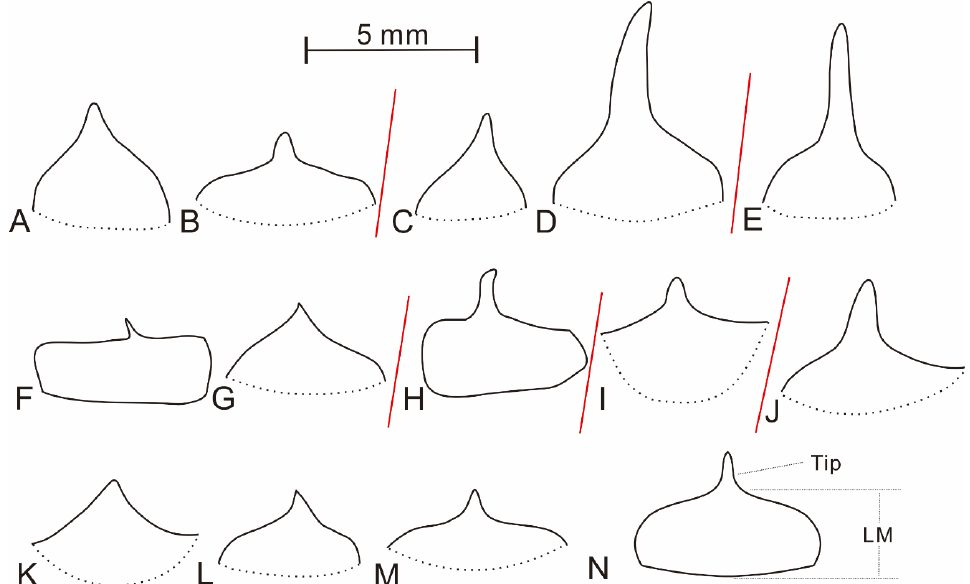
Figure 4. Line-drawings of leaf appearances of Barsassia ornata [17] from different localities and a leaf shape diagram. ( A ) From Figure 1 of [17], under the name of Barsassia ornata from the Middle Devonian of Barzas, southwestern Siberia, Russia. ( B ) From Figure 2 of [17], under the name of Barsassia ornata from the Middle Devonian of Barzas, southwestern Siberia, Russia. ( C – D ) From Plate XVV. Figure 8 of [20], under the name of Barsassia ornata from the Middle Devonian of Barzas, southwestern Siberia, Russia. ( E ) From Plate XVV. Figure 2 of [20], under the name of Barsassia platyphylla from the Middle Devonian of Barzas, southwestern Siberia, Russia. ( F ) From Plate 201. Figure 11 of [9]; under the name of Barsassia sibirica from the Middle Devonian of West Junggar Basin, Xinjiang, China. ( G ) From Plate 201. Figure 4 of [9], under the name of Barsassia sibirica from the Middle Devonian of West Junggar Basin, Xinjiang China. ( H ) From Plate LXIV. Figure 2 of [21], under the name of Barsassia grandis from the Middle Devonian of Katbas Mountains, Kazakhstan. ( I ): From Plate LXIV. Figure 6 of [21], under the name of Barsassia plana from the Middle Devonian of Katbas Mountains, Kazakhstan. ( J ) From Plate 4 of [34], under the name of Barsassia ornata from the Middle Devonian of southwestern Siberia, Russia. ( K – M ) Based on the Figure 1B of this study,